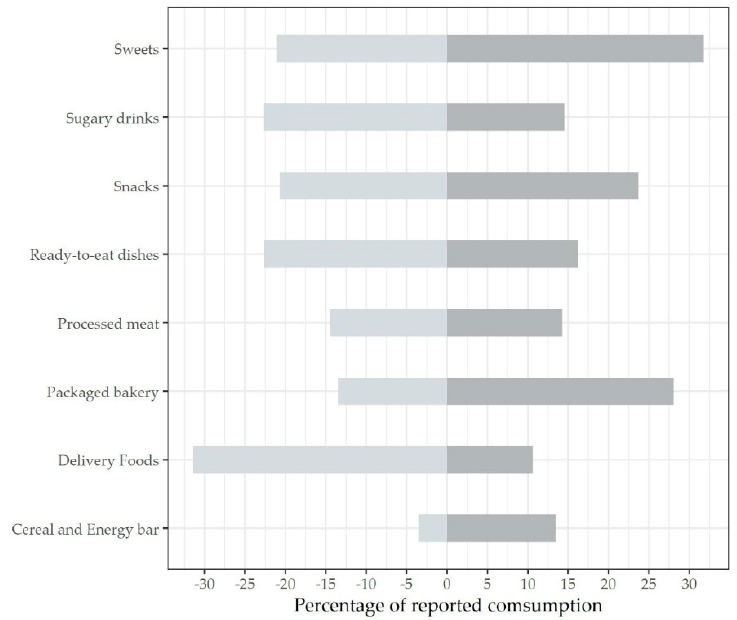
Figure 2. Percentage of reported consumption .